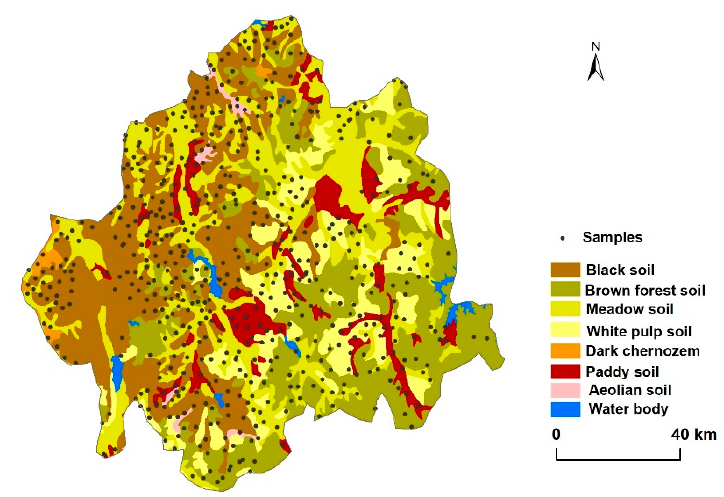
Figure 3. Distributions of soil types and sampling points. Table 1. Approximate correspondences of soil groups between Chinese soilclassification and Food and Agriculture Organization (FAO) reference soil taxonomy.